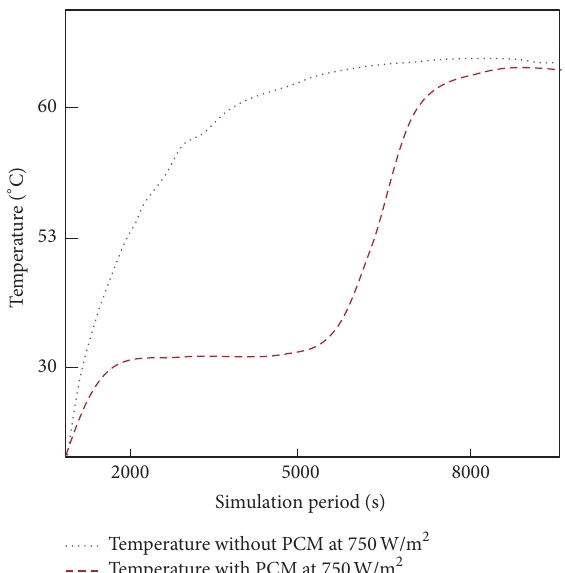
Temperature versus hrs.